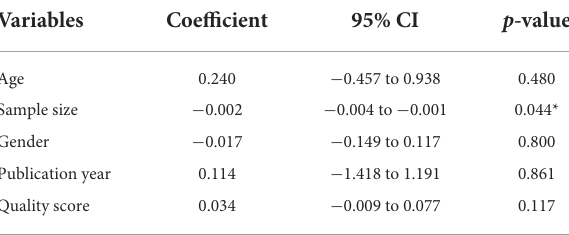
TABLE 2 The univariate meta-regression analysis on the heterogeneity of the determinants in included studies for the prevalence of